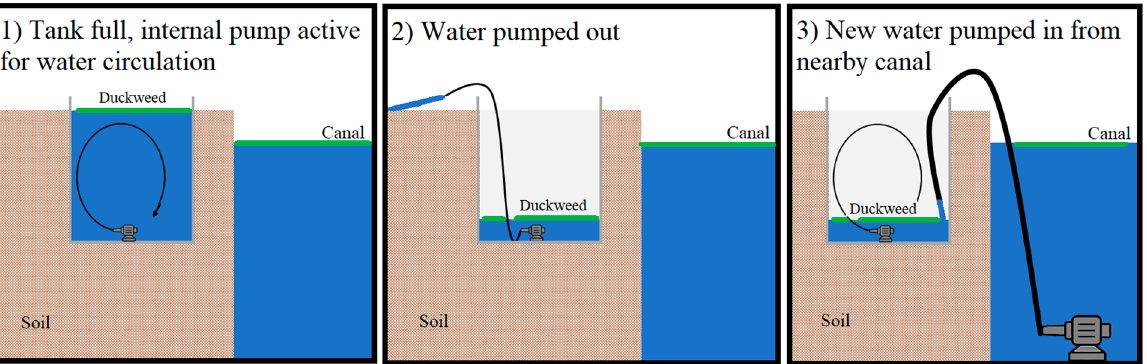
Figure 2. Experimental design. Tanks are buried next to a canal with aquaculture effluent. The tank is filled with aquaculture effluent ( 1 ). Twice a day, the tank is emptied without disrupting the bio ‐ film or duckweed mat ( 2 ) and re ‐ filled with fresh aquaculture effluent from the nearby canal ( 3 ).